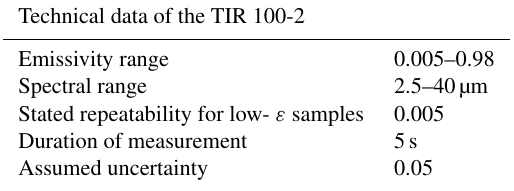
Table 1. Specifications of the TIR